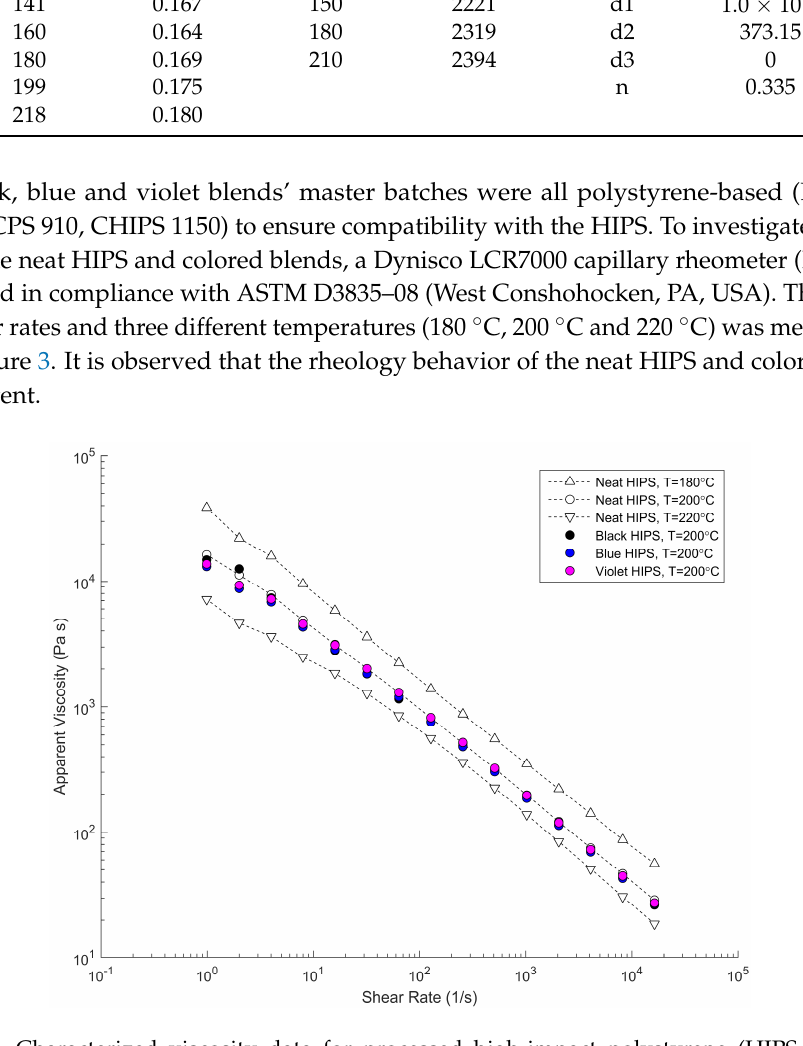
Figure 3. Characterized viscosity data for processed high‐impact polystyrene (HIPS 478) and compounded black, blue, and violet blends (CHIPS 1137, CPS 910, CHIPS 1150).